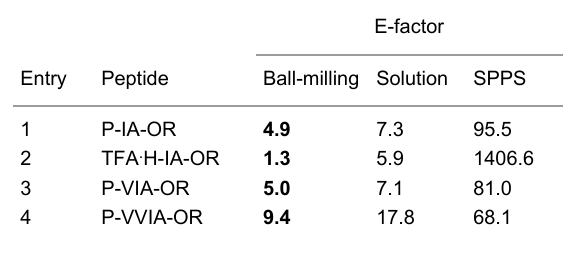
Table 2: Comparison of the E-factor between the three strategies (for each entry, the best result is indicated in